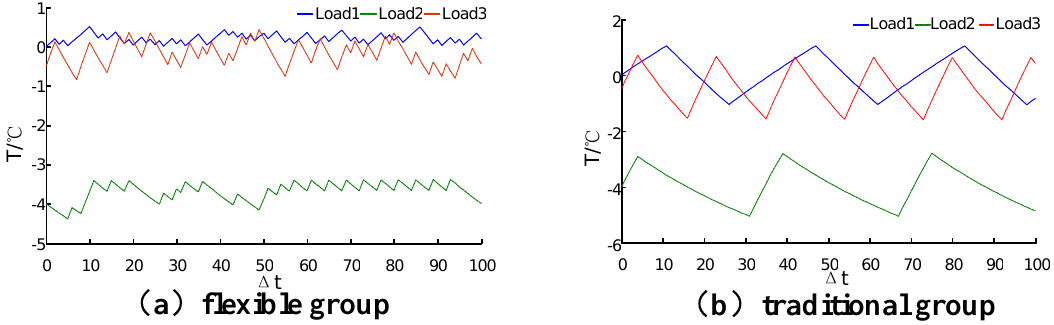
Figure 6. The function indexes comparison of refrigerator loads under normal condition; ( a ) flexible group; ( b ) traditional group.